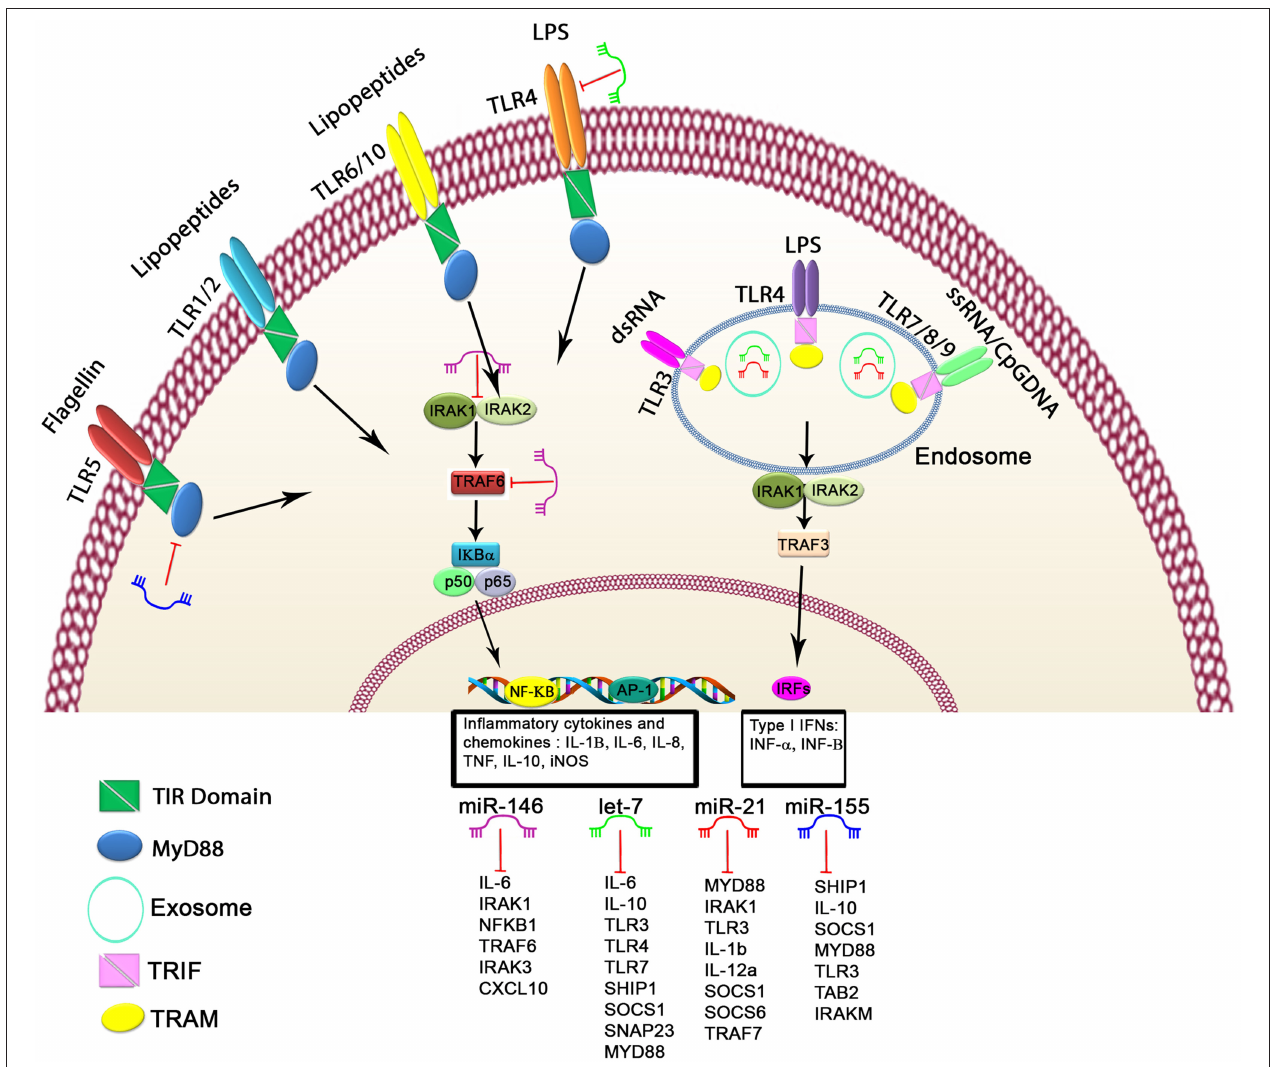
FIGURE 1 | Schematic of the regulatory mechanism of miRNAs in TLR signaling. Cell surface and cytoplasmic TLRs can be regulated by several miRNAs, including let-7 family members, miR-21, miR-146, and miR-155. First, miRNAs can bind directly to 3 ′ untranslated region of TLRs or TLR-related genes, leading to modulated expression of TLRs through posttranscriptional regulation of TLR signaling. Second, miRNAs serve as physiological ligands of TLRs, such as miR-21, let-7 family members, and miR-29a, which can activate TLR signaling and stimulate the release of inflammatory cytokines and IFN genes in some cell types. Functional studies have demonstrated that these miRNAs may participate in activation of TLR signaling through regulating the NF- κ B pathway and the production of inflammatory cytokines, which are shown